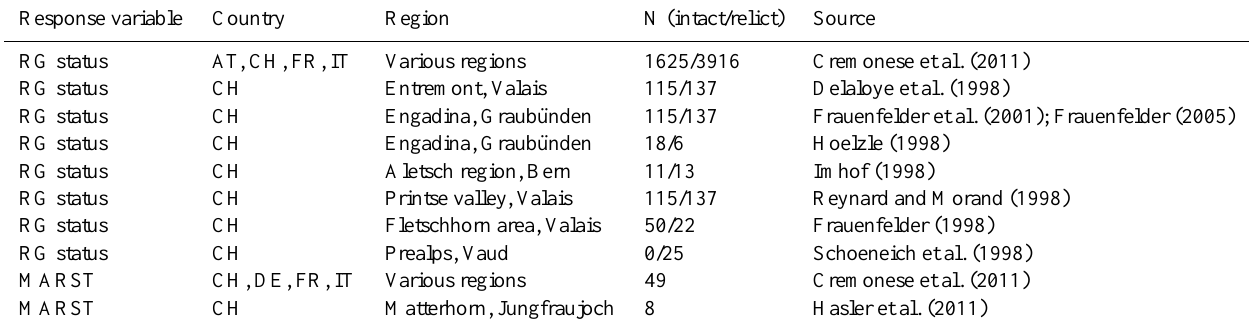
Table 1. Overview of data used for model calibration (RG Rock glacier; AT Austria, CH Switzerland, DE Germany, FR France, IT Italy).